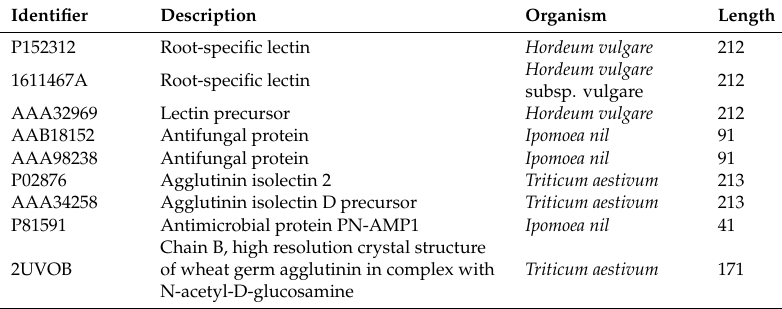
Figure 1. Schematic representation of the conserved domains present in the CaChiIII7 protein. The scale bar indicates the length of protein (aa). The details of conserved domains were retrieved from online tool Conserved Domain Database (CDD) [59]. Table 1. Identification of chitin-binding domain(s) and their function in different crops